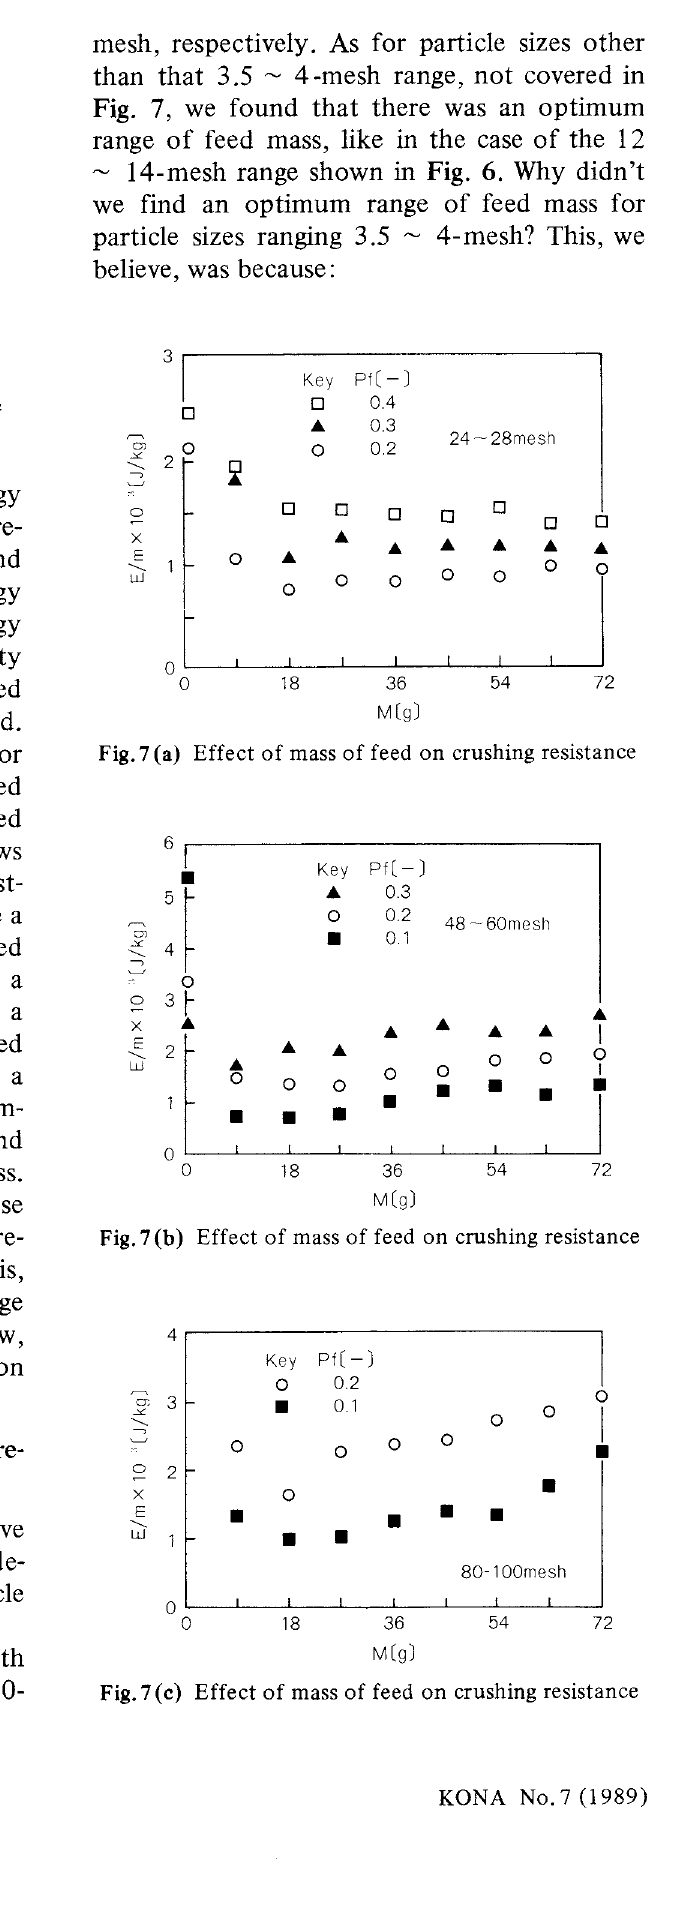
Fig. 7 (c) Effect of mass of feed on crushing